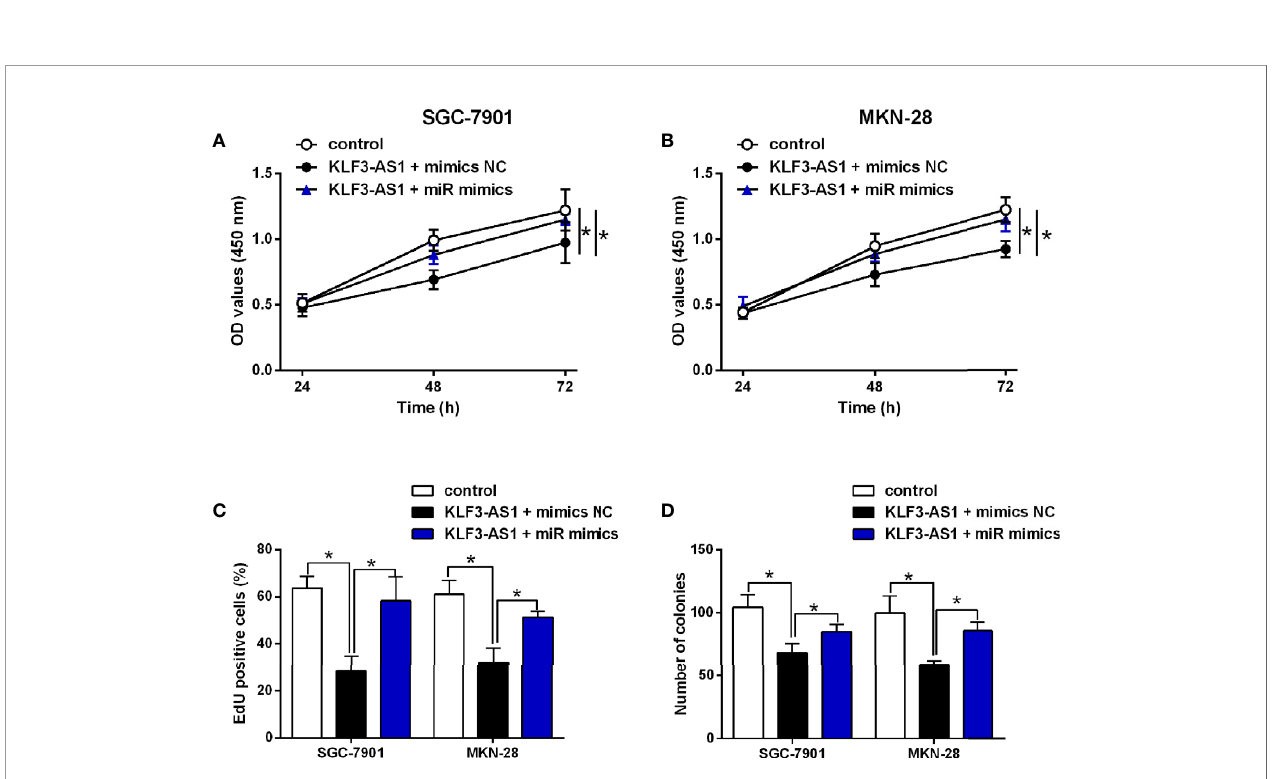
FIGURE 4 | MiR-223 attenuated the effects of KLF3-AS1 on the gastric cell viability, proliferation. SGC-7901 and MKN-28 cells were co-transfected with pcDNA3.1 + mimics NC (control group), pcDNA3.1-KLF3-AS1 + mimics NC, or pcDNA3.1-KLF3-AS1 + miR-223 mimics, at 24 h after transfection, (A, B) cell viability of SGC-7901 and MKN-28 cells was determined by CCK-8 assay; (C) cell proliferation of SGC-7901 and MKN-28 cells was determined by EdU assay; (D) cell growth of SGC-7901 and MKN-28 cells was determined by colony formation assay (one-way ANOVA followed by Bonferroni ’ s test). N = 3; *P <